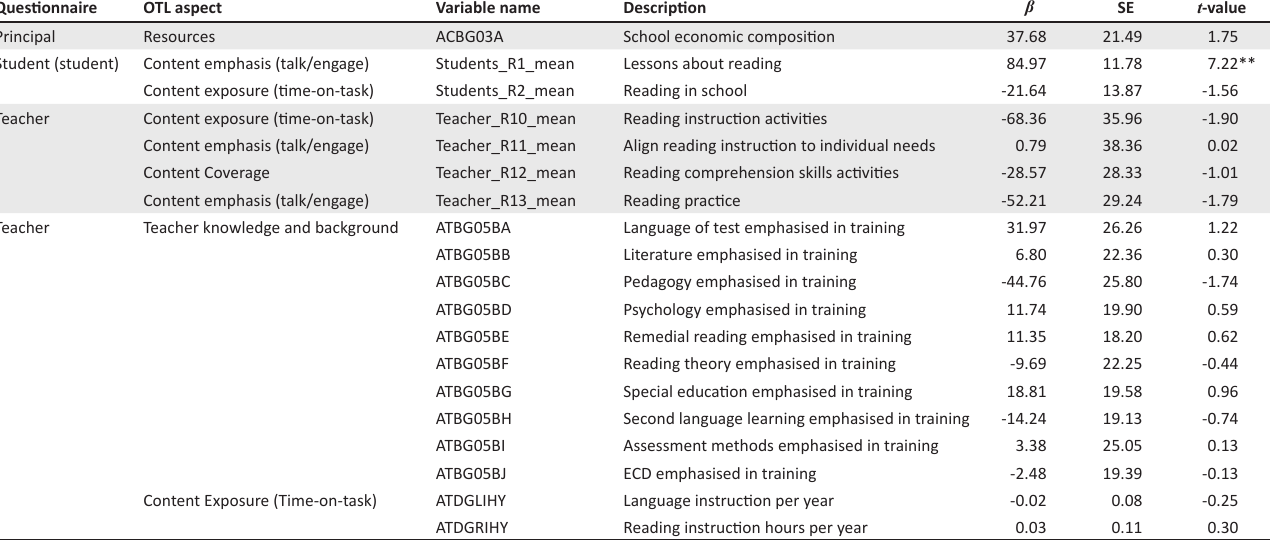
TABLE 4: Regression results for opportunity to learn when controlling for teachers’ background and school composition.